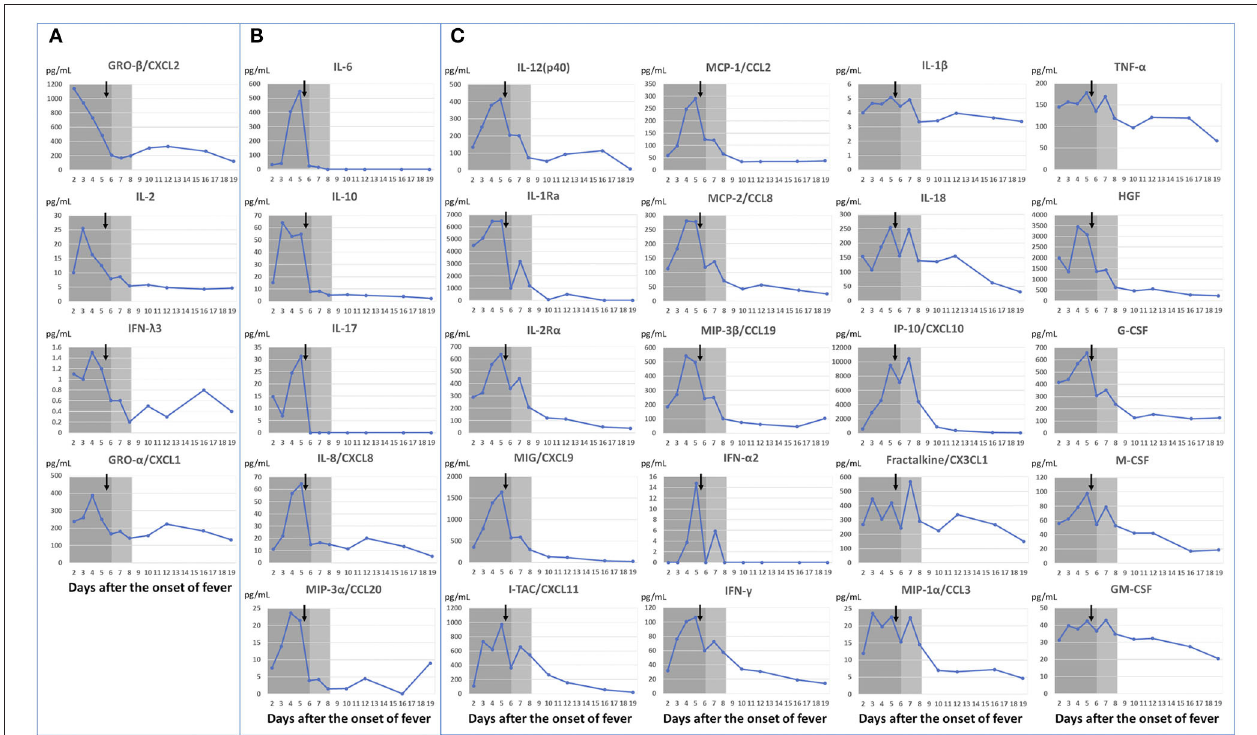
FIGURE 3 | Dynamic changes in cytokines according to changes in clinical symptoms. Febrile period shown in dark gray; duration of myocarditis shown in light gray. ↓ indicates IVIG + PSL + ASA start timing. Dots represent blood draw timings. (A) Cytokines with peak titers before treatment initiation. (B) Cytokines with rapid reductions following fever resolution. (C) Cytokines that persisted at high titers for an extended period following fever resolution, which then decreased with amelioration of myocarditis. ASA, aspirin; IVIG, intravenous immunoglobulin; PSL, prednisolone; IL, interleukin; MIP, macrophage inflammatory protein; IFN, interferon; MCP, monocyte chemoattractant protein; MIG, monokine induced by interferon- γ ; IP, interferon- γ -induced protein; TNF, tumor necrosis factor; HGF, hepatocyte growth factor; G-CSF, granulocyte colony-stimulating factor; M-CSF, macrophage colony-stimulating factor; GM-CSF, granulocyte-macrophage colony-stimulating